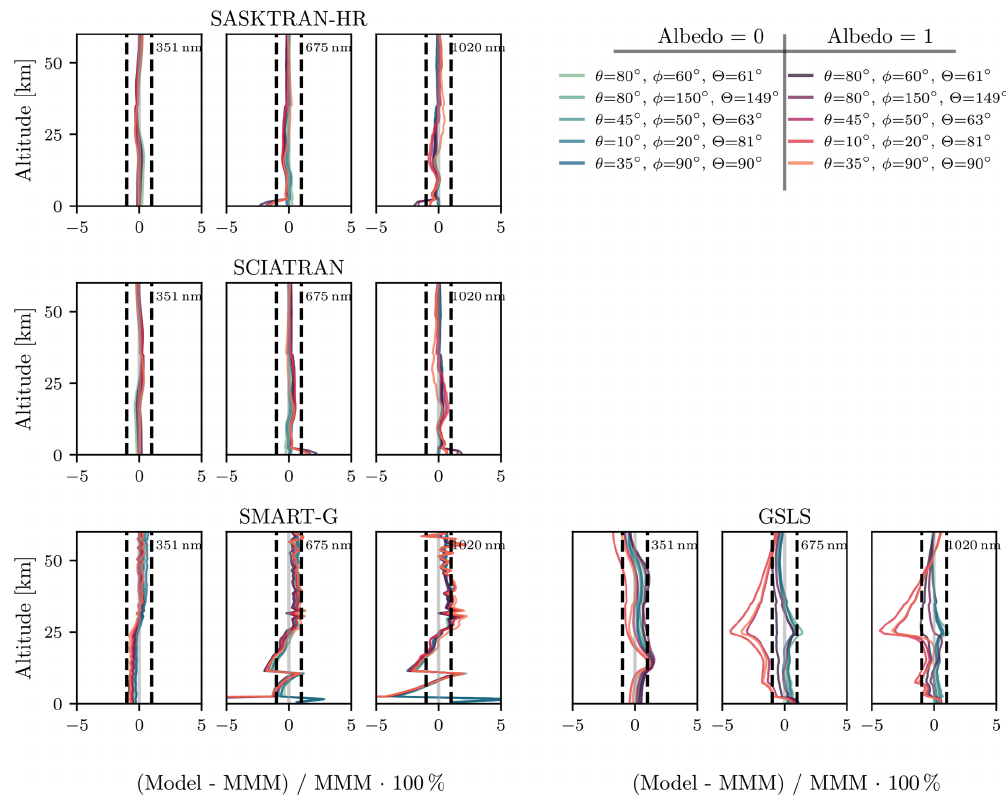
Figure 8. Same as Fig. 4 but with refraction enabled. The MMM is composed of SASKTRAN and SCIATRAN. Dashed vertical lines indicate ± 1% levels.